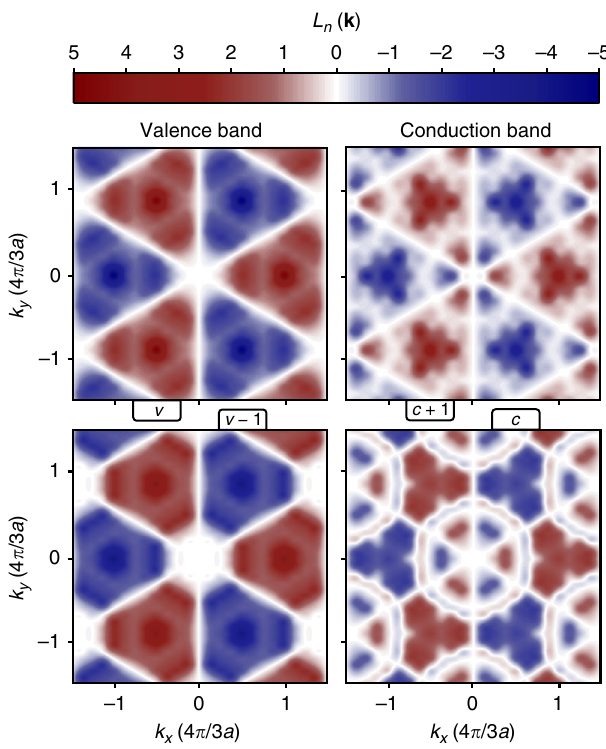
Fig. 5 Orbital angular momentum of the highest valence bands and lowest conduction bands in monolayer WSe 2 from DFT. Orbital angular momentum in the fi rst Brillouin zone for the highest valence bands v and v − 1 (left panels) and lowest conduction bands c and c + 1 (right panels) from DFT calculations including spin – orbit